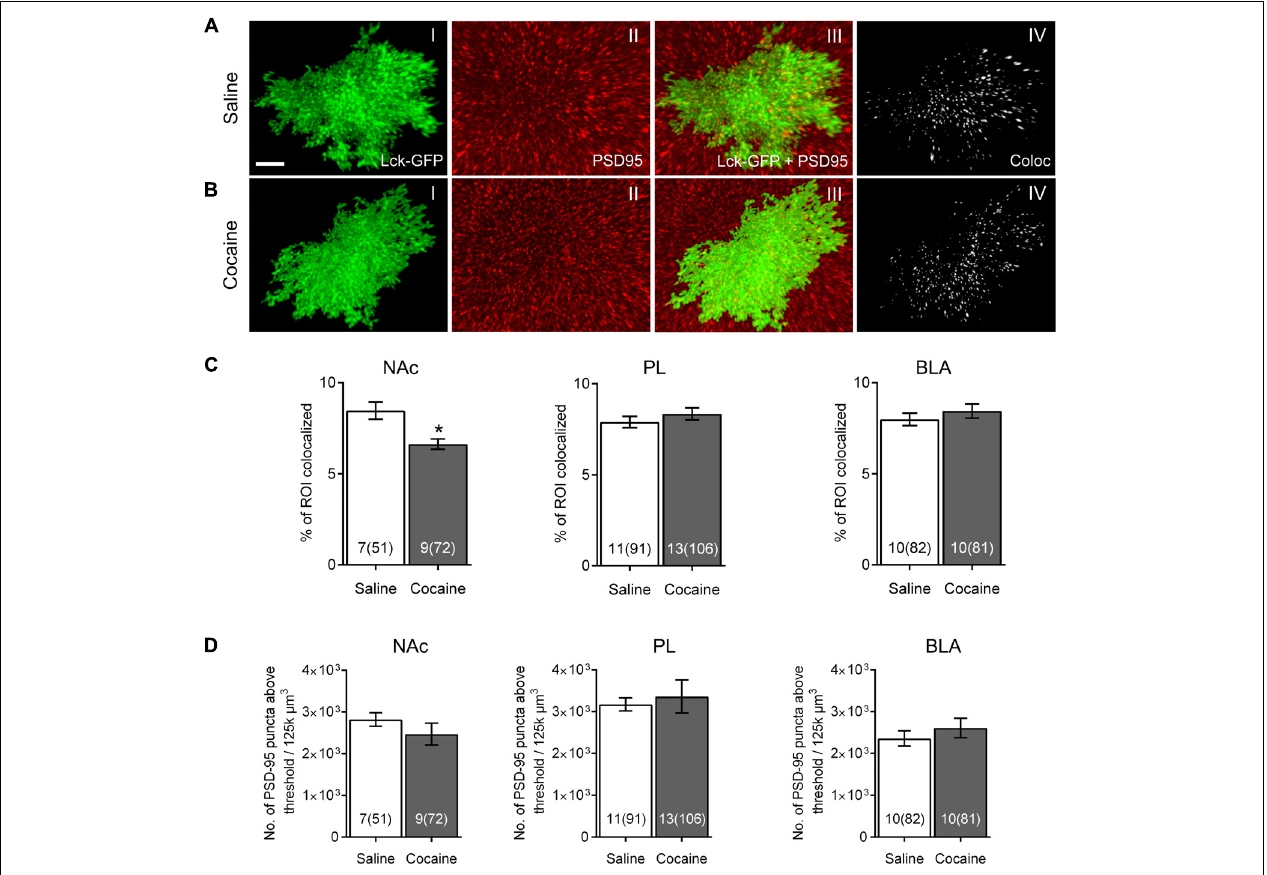
FIGURE 3 | Colocalization between astrocytes and post-synaptic marker PSD-95 following cocaine SA and extinction in NAc, PL, and BLA. (A) Isolated Lck-GFP signal from a single NAc astrocyte (I) from a saline-experienced rat and the same area, stained for neuronal post-synaptic marker PSD-95 (II). Both signals were overlapped (III) and Imaris was used to isolate the PSD-95 signal colocalized with Lck-GFP (IV). (B) Same as in (A) , an astrocyte from a cocaine-extinguished rat. (C) Imaris was used to evaluate the percentage of isolated astrocyte Lck-GFP signal (ROI) colocalized with the PSD-95 signal. Significant difference in % of ROI colocalized between cocaine- and saline-administering rats was found in the NAc, but not in the PL or BLA regions. Bar insert: number of animals and number of cells (in parentheses). (D) Automated counting of PSD-95 positive puncta above the previously determined threshold level showed no difference in PSD-95 expression in any of the selected brain regions following cocaine versus self-administration and extinction. Bar insert: number of animals and number of cells (in parentheses). ∗ p < 0.05 by nested